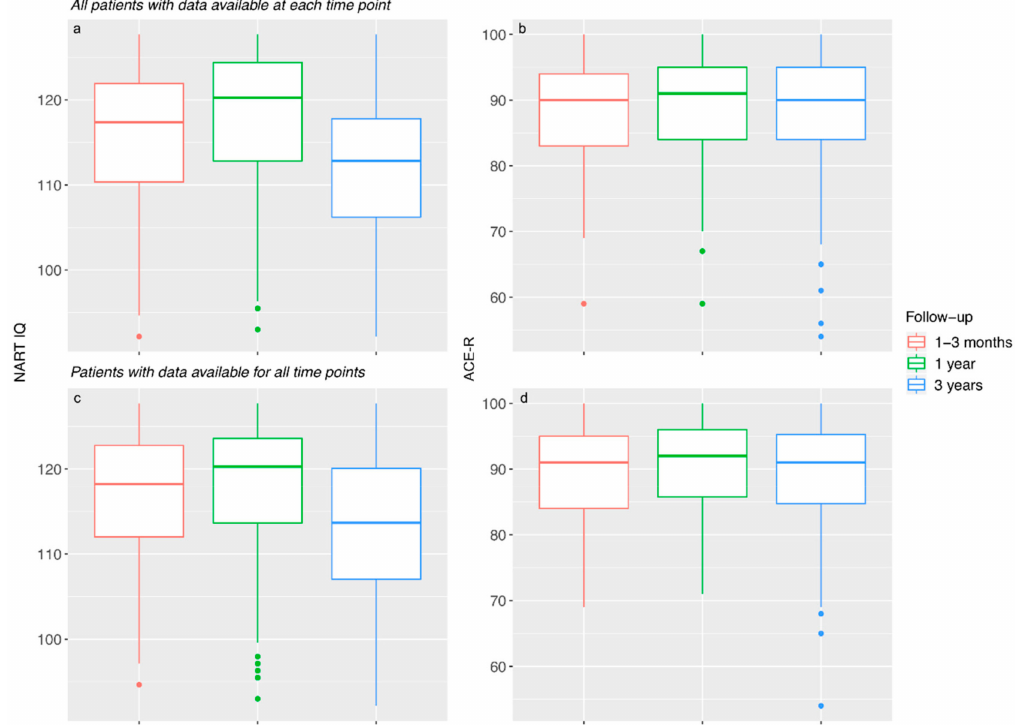
Figure 2. NART IQ and ACE-R scores by time-point ( a ) NART IQ scores by time-point for patients with data available at each time-point. ( b ) ACE-R scores by time-point for patients with data available at each time-point. ( c ) NART-IQ scores by time-point for patients with data available at all three time-points. ( d ) ACE-R scores by time-point for patients with data available at all three time-points. Between one and three years ( n = 101), NART IQ decreased significantly by − 4.269 points (95% CI − 5.124 to − 3.414, p < 0.001). During this period, 12 / 101 (12%) improved, 82 / 101 (81%) declined, and 7 / 101 (7%) did not